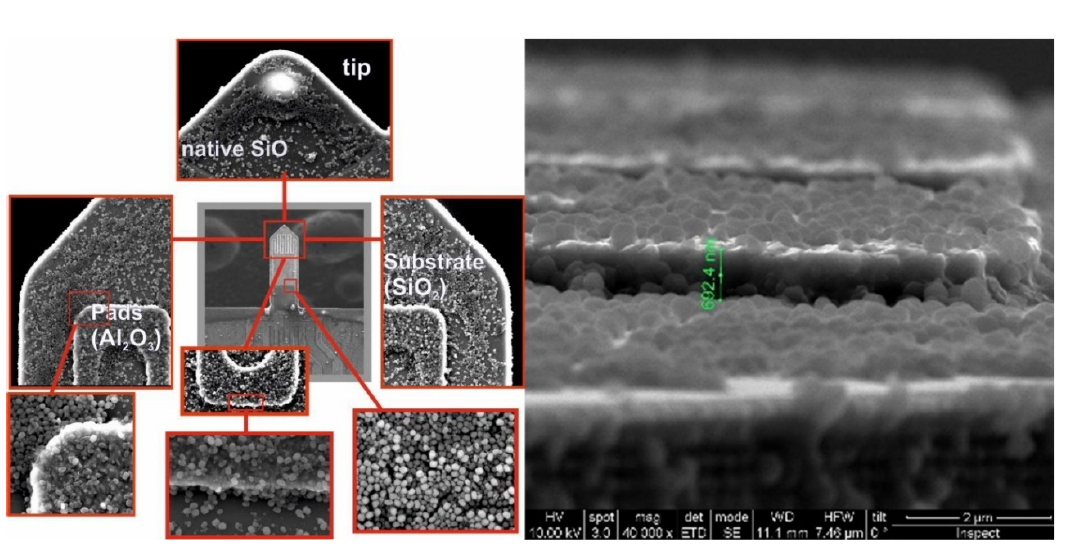
Figure 7. SEM images of the mesoporous silica coating on the top of the microcantilever obtained by self-assembly of MCM-48 nanoparticles onto plasma activated surfaces (cantilever #166).